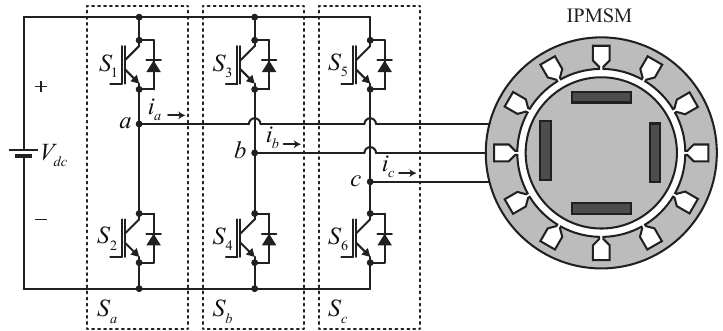
Figure 1. Three phase two-level topology VSI fed